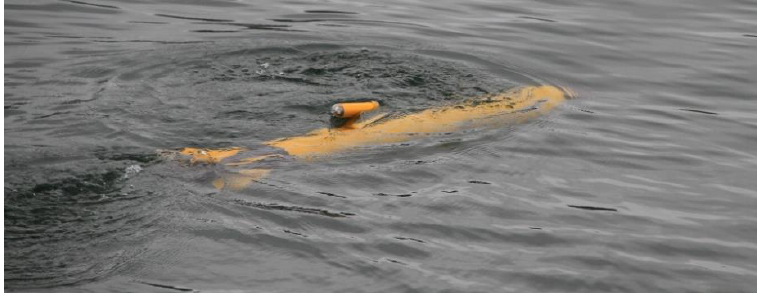
Figure 26. ZFAUV in lake.